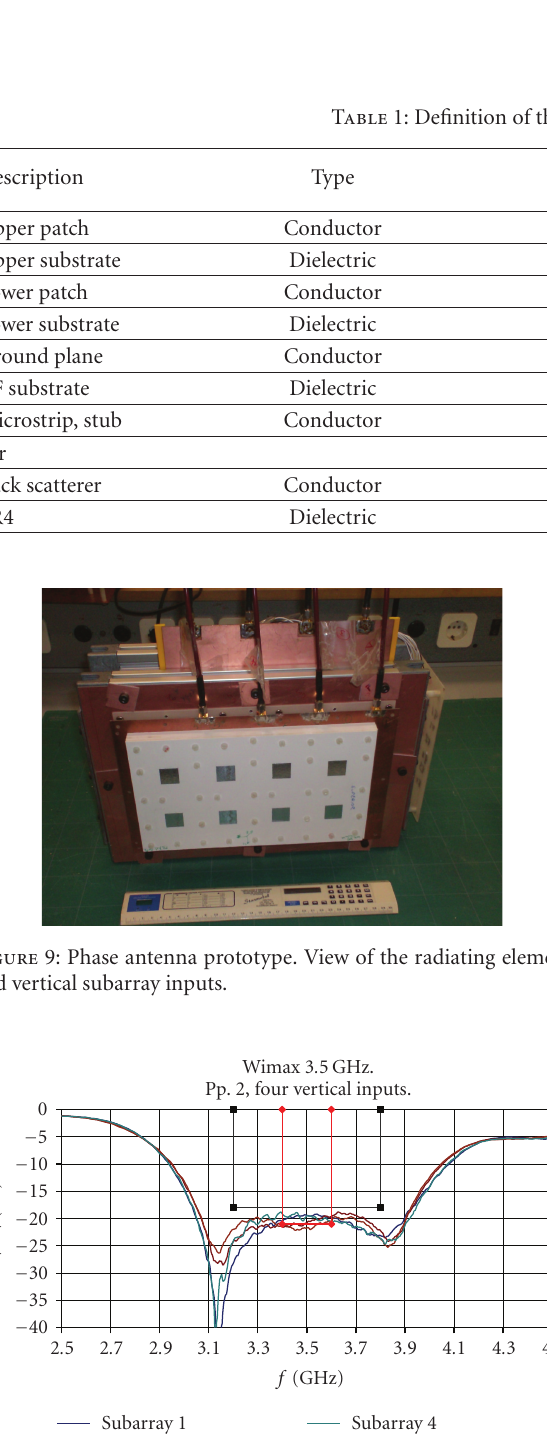
conductors of the radiating element and their description. In Table 1, the stack of the antenna and the parameters of the elements of the radiating element are listed.